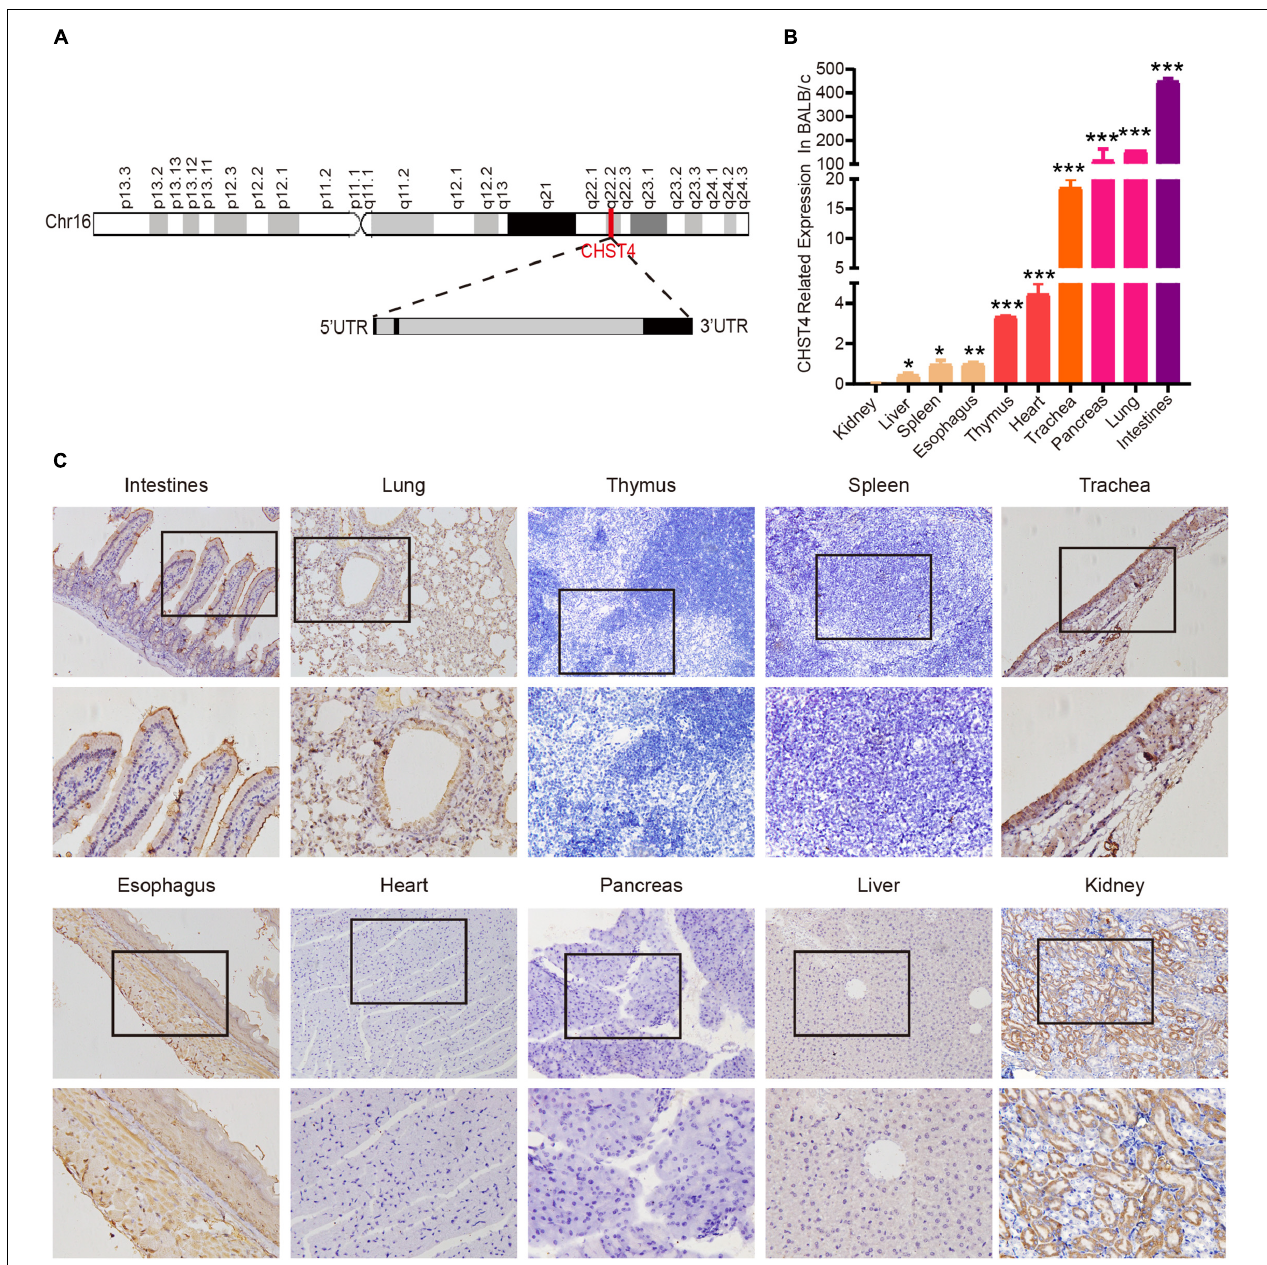
FIGURE 1 | Structure of the carbohydrate sulfotransferase 4 (CHST4) gene and its distribution in BALB/c mice tissues. (A) Chromosome location (red line; top) and gene structure of CHST4 (bottom; black boxes represent exons and gray boxes represent introns). (B) Relative expression of CHST4 mRNA in various tissues of BALB/c mice by quantitative real-time (qRT)-PCR. GAPDH was used as the loading control. Bars represent the mean ± SD ( n = 4); * P < 0.05, ** P < 0.01, *** P < 0.001 (Student’s t -test). All samples were tested in triplicate. (C) Immunohistochemical analysis of the expression and distribution of CHST4 protein in BALB/c mice tissues (100 × ; 400 × ; four samples in each